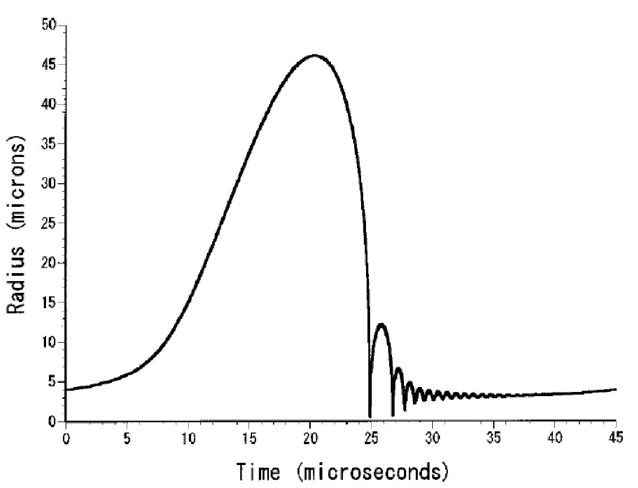
Figure 3. The calculated radius-time curve of an argon bubble in water for one acoustic cycle when the frequency and the amplitude of ultrasound are 22 kHz and 1.32 bar, respectively and the ambient bubble radius is 4 μ m [27]. Copyright 2002, with the permission of AIP Publishing.